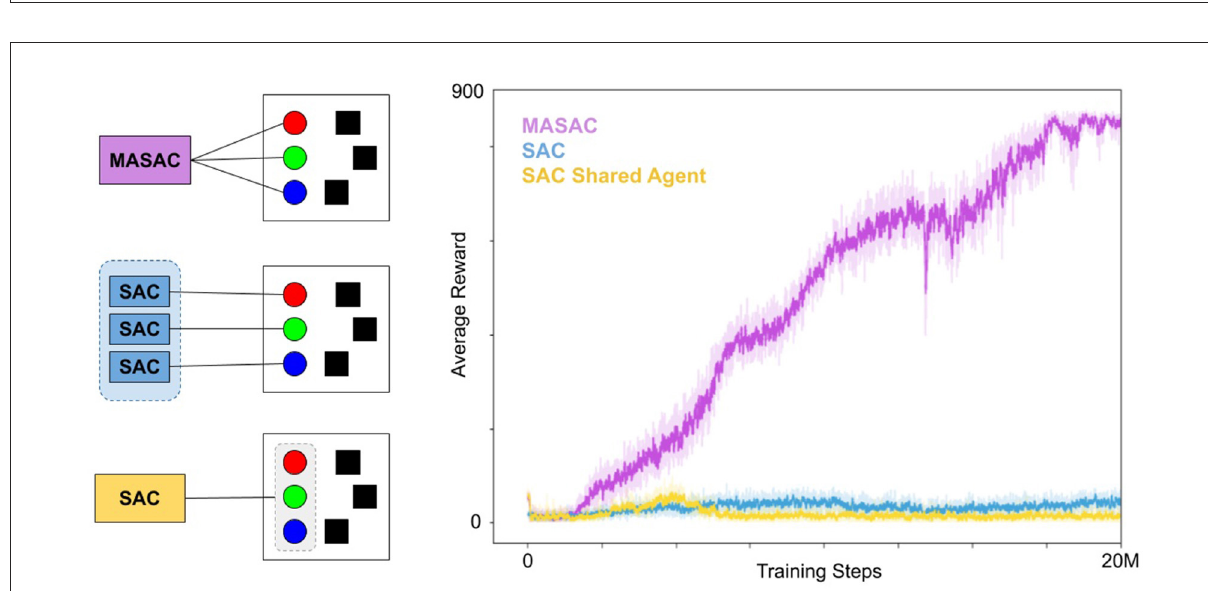
FIGURE8 Training curves for MASAC and comparisons. (Left) Entity assignments for the three approaches: Truly multiagent policy (MASAC), treating each entity as an SAC worker, and grouping all entities into a single agent. In all cases, the assignment was duplicated over several environments for distributed training. (Right) The corresponding training curves for each approach. MASAC was the only successful algorithm, making slow and deliberate progress for roughly 18 million steps before leveling off.